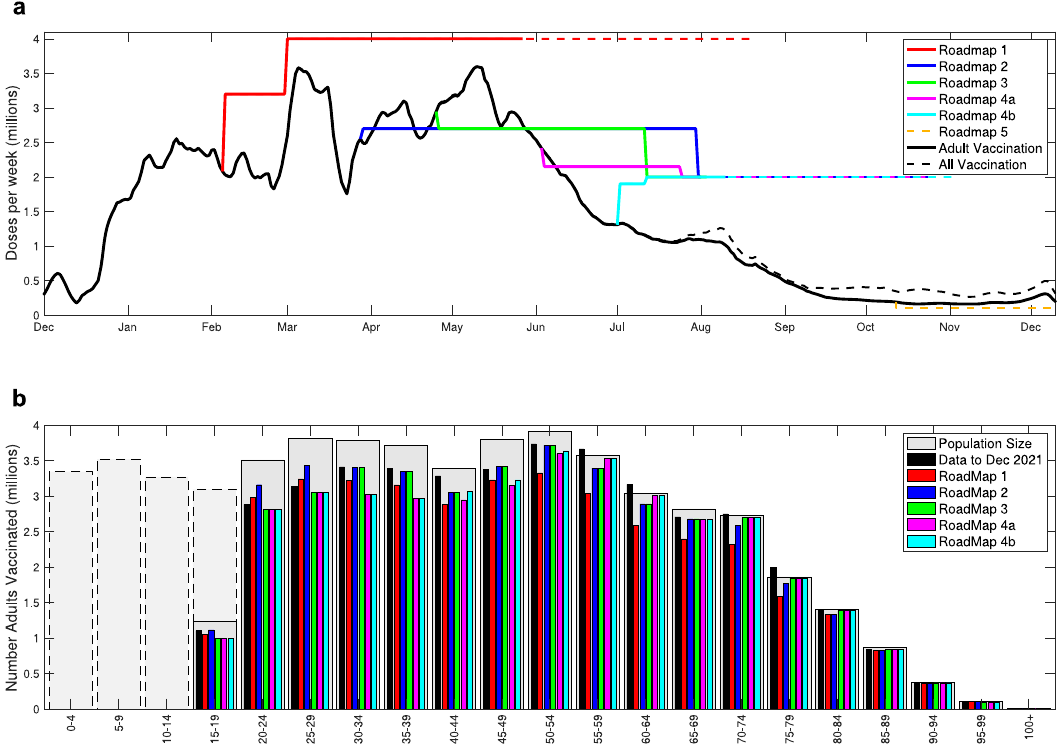
Fig. 2 | Assumptions about the vaccine uptake for the six roadmap models. a Realiseddeliveryof vaccine in England, from December 2020 to December 2021 (blacklinesrepresenta7-daymovingaverage),comparedwithassumptionsforthe six Roadmap documents. The solid lines correspond to the time to give two doses toalladults(18+)attheassumeduptake;theblacksolidlineisthereportedrateof adult vaccination, while the black dashed line is the combined rate of vaccinating